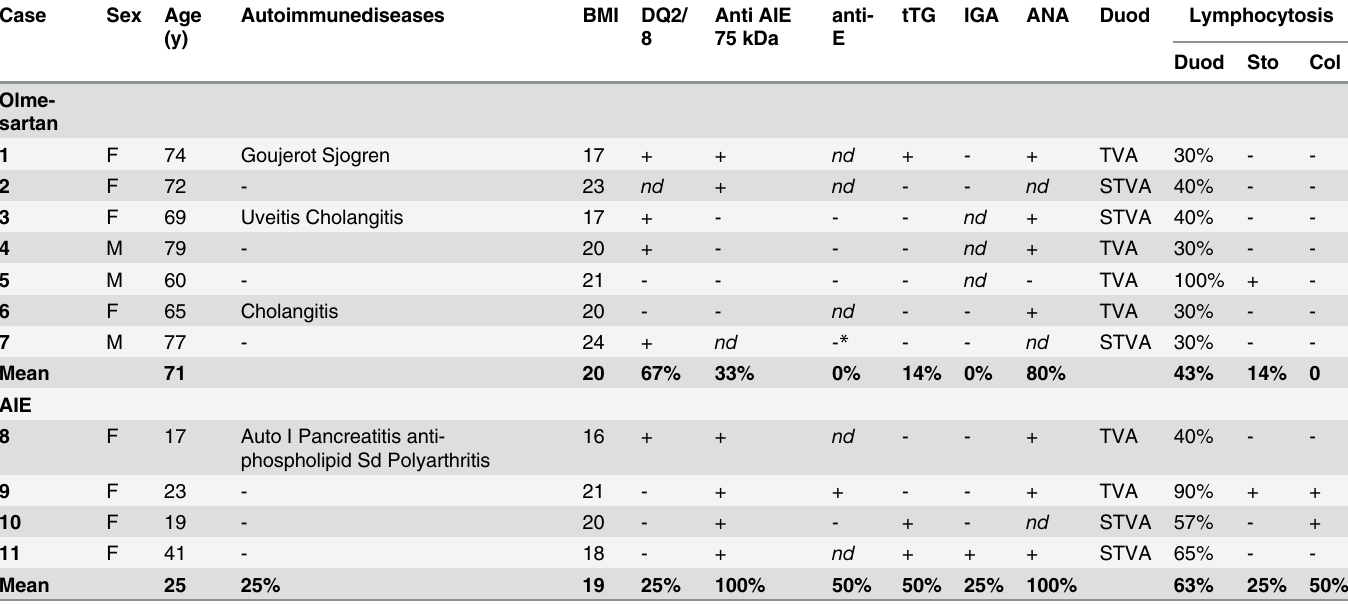
Table 1. Clinical and immune characteristics.